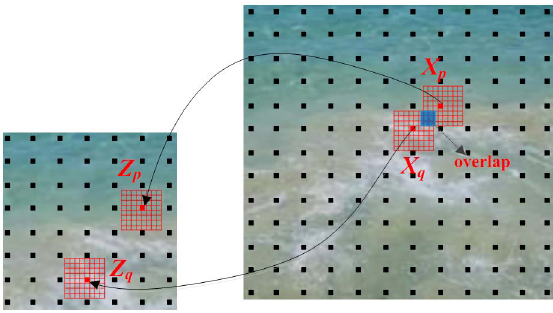
Figure 5. Energy optimization process on sparse.